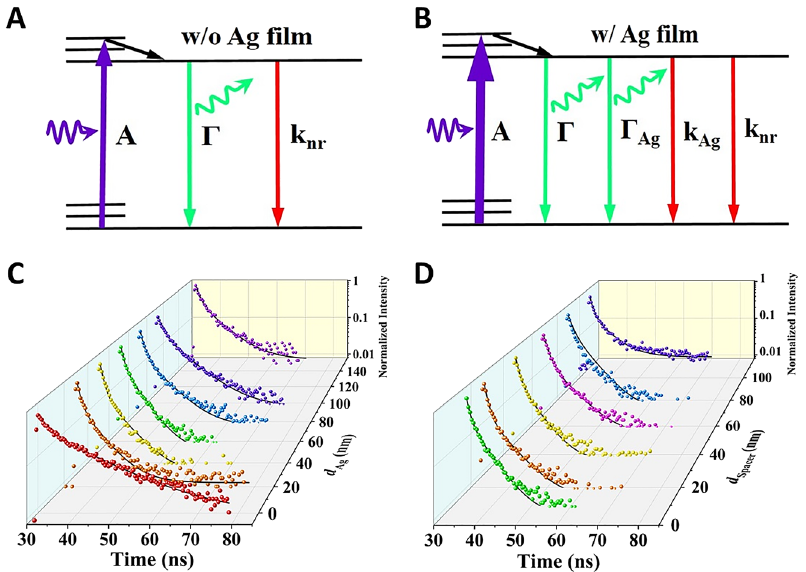
Figure 5: The energy diagrams and time resolved PL spectra for CPB